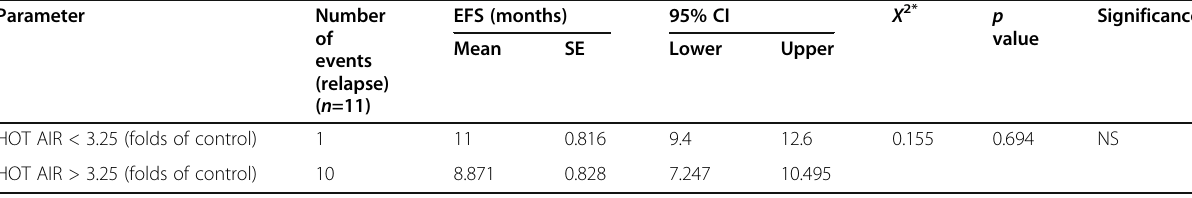
Table 8 Relationship of HOTAIR expression and EFS Parameter